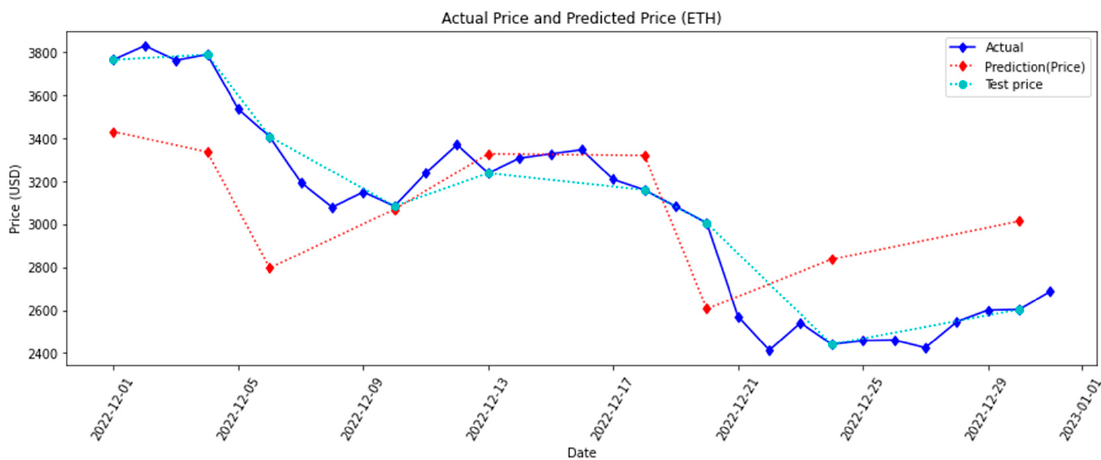
Figure 14. The plot of actual, test, and predicted trends in Ethereum.